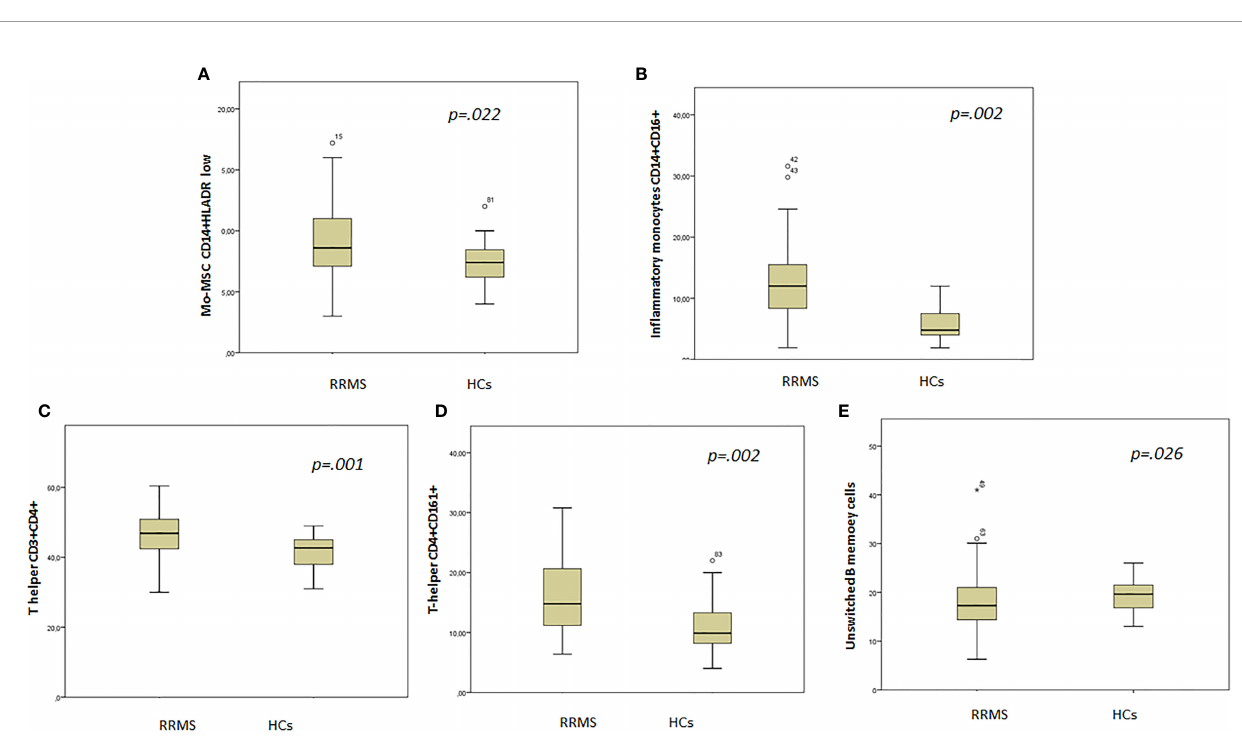
FIGURE 3 | Box plot showing statistically different cell subsets between groups. (A) Mo-MDSC CD14+HLADR low; (B) in fl ammatory monocytes CD14+CD16+; (C) T helper CD3+ CD4+; (D) T helper CD4+CD161+; (E) unswitched B memory